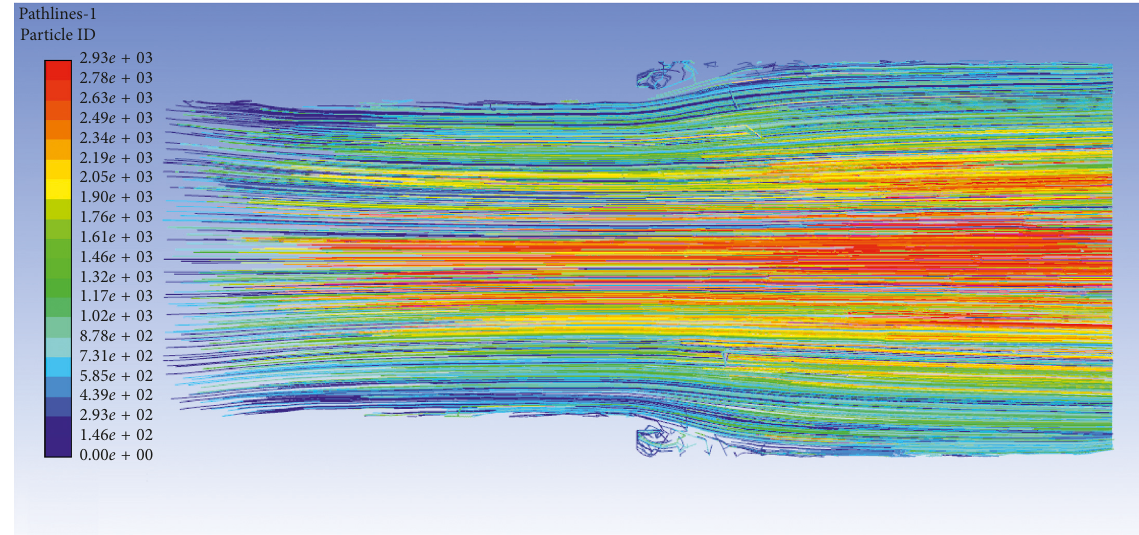
Figure 8: Sudden extension ratio is 1.25.